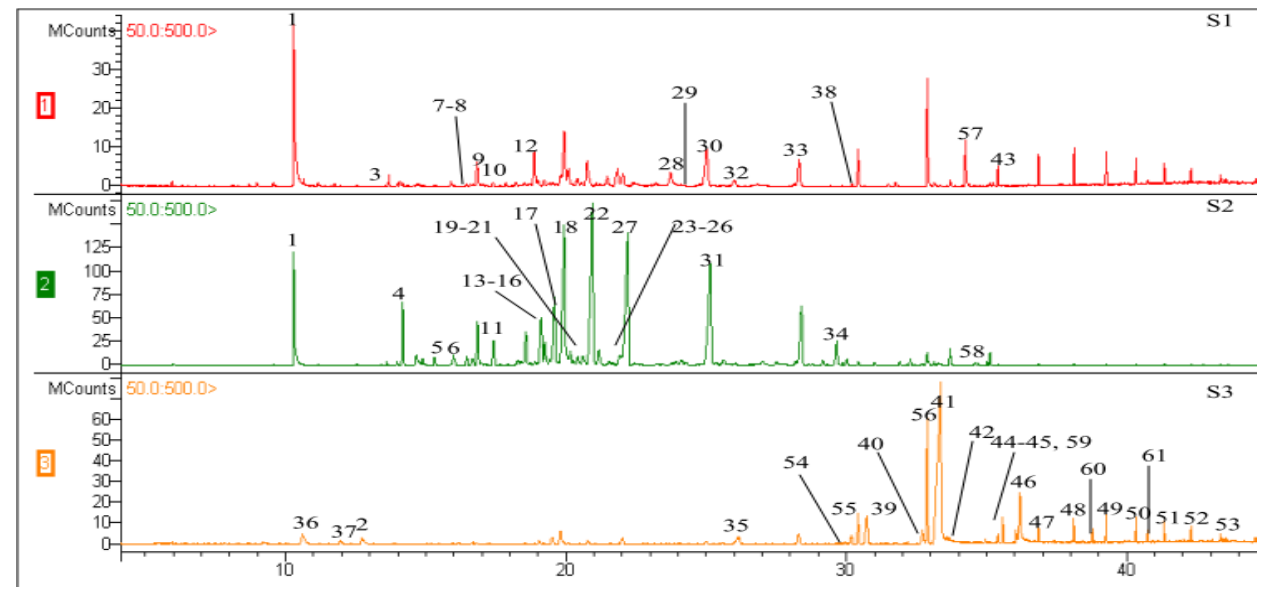
Figure 2. GC chromatograms of the three essential oils. Component numbers in the chromatogram come from Table